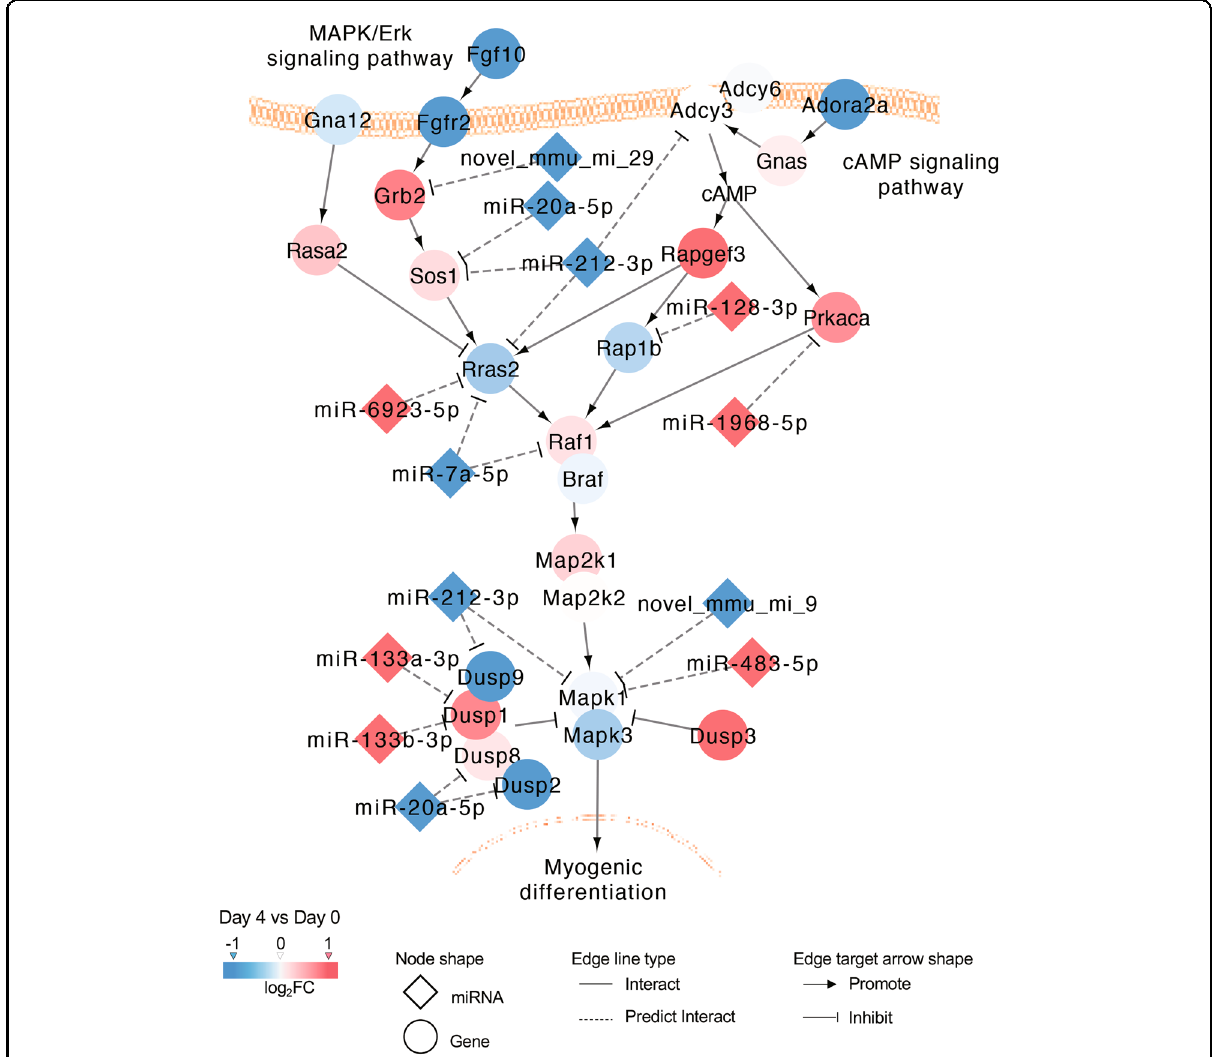
Fig. 7 Differentially expressed miRNAs involved in the MAPK signaling pathway and their target genes. Orange red and light red indicate upregulation on day 4 compared with day 0 (orange red, log 2 FC > 1; light red, 0 < log 2 FC < 1), whereas blue and light blue indicate downregulation over this same period (blue, log 2 FC < − 1; light blue, − 1 < log 2 FC <